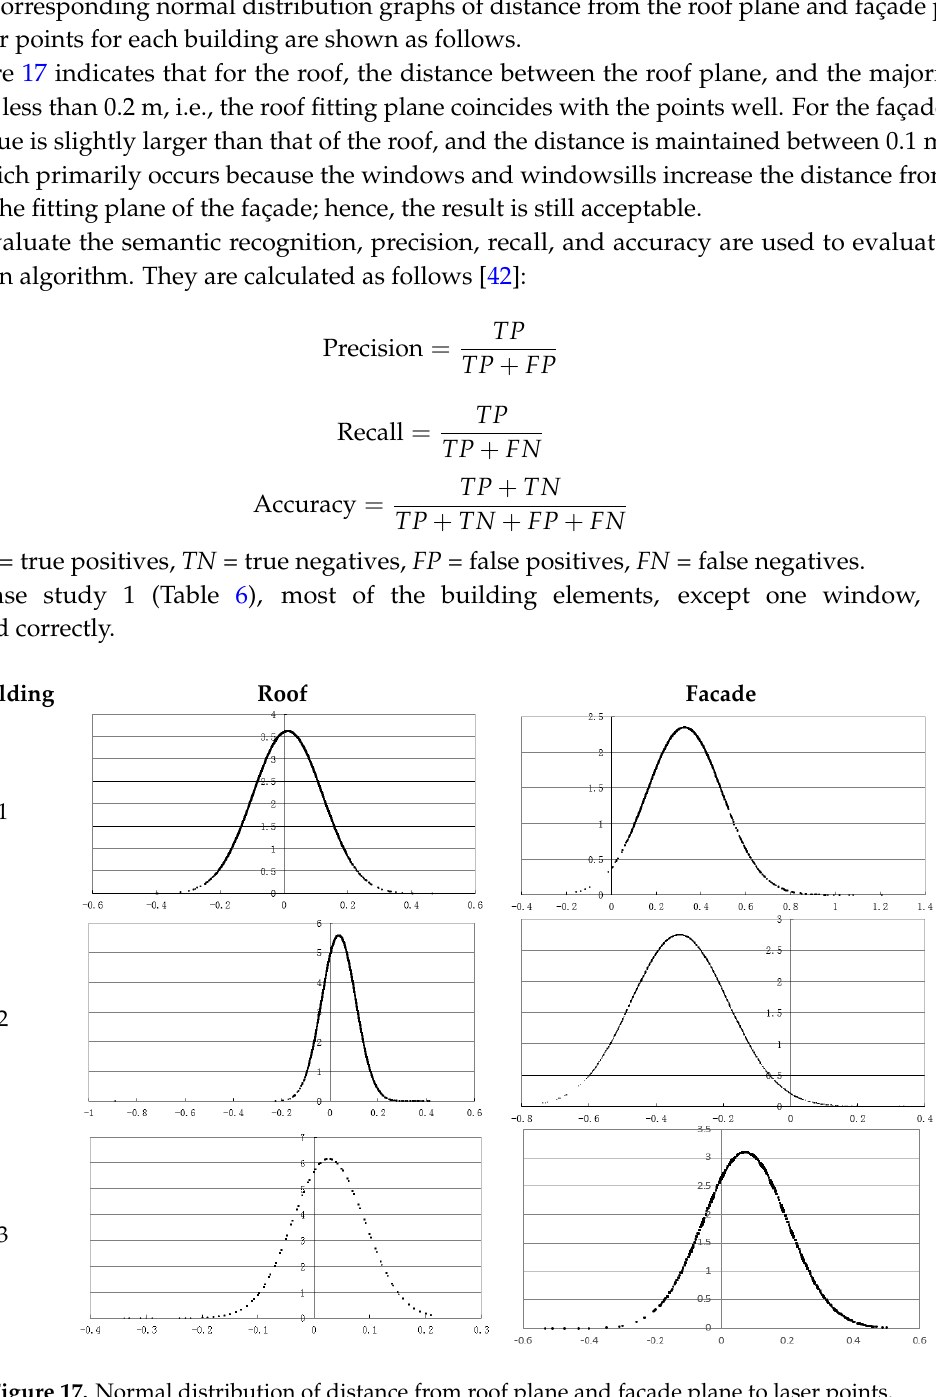
Table 7. Evaluation of semantic recognition for case study 2. TP FP FN TN Precision (%) Recall (%) Accuracy (%) Floor